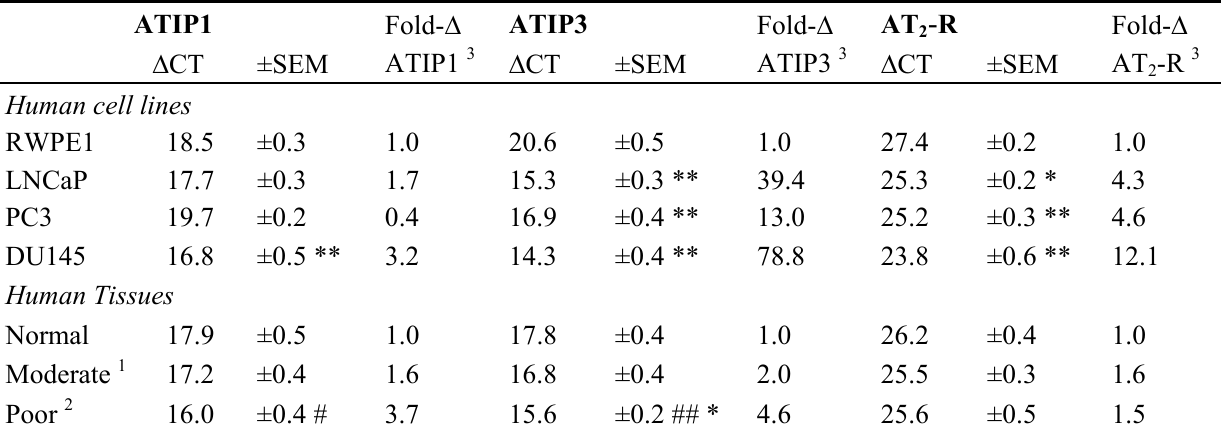
Table 1. Expression of ATIP1, ATIP3 and AT lines and